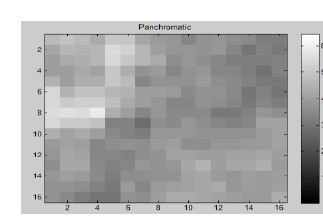
Figure 1. Panchromatic 16 ×16 pixels data